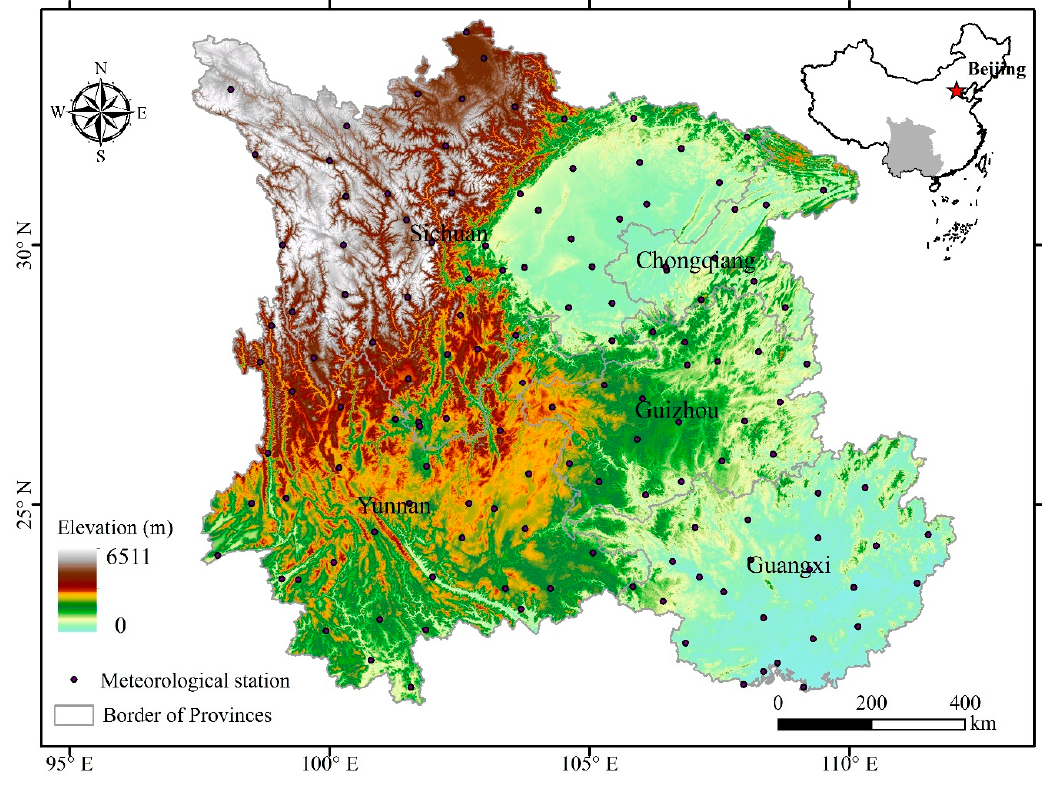
Figure 1. Location of the Southwest China.